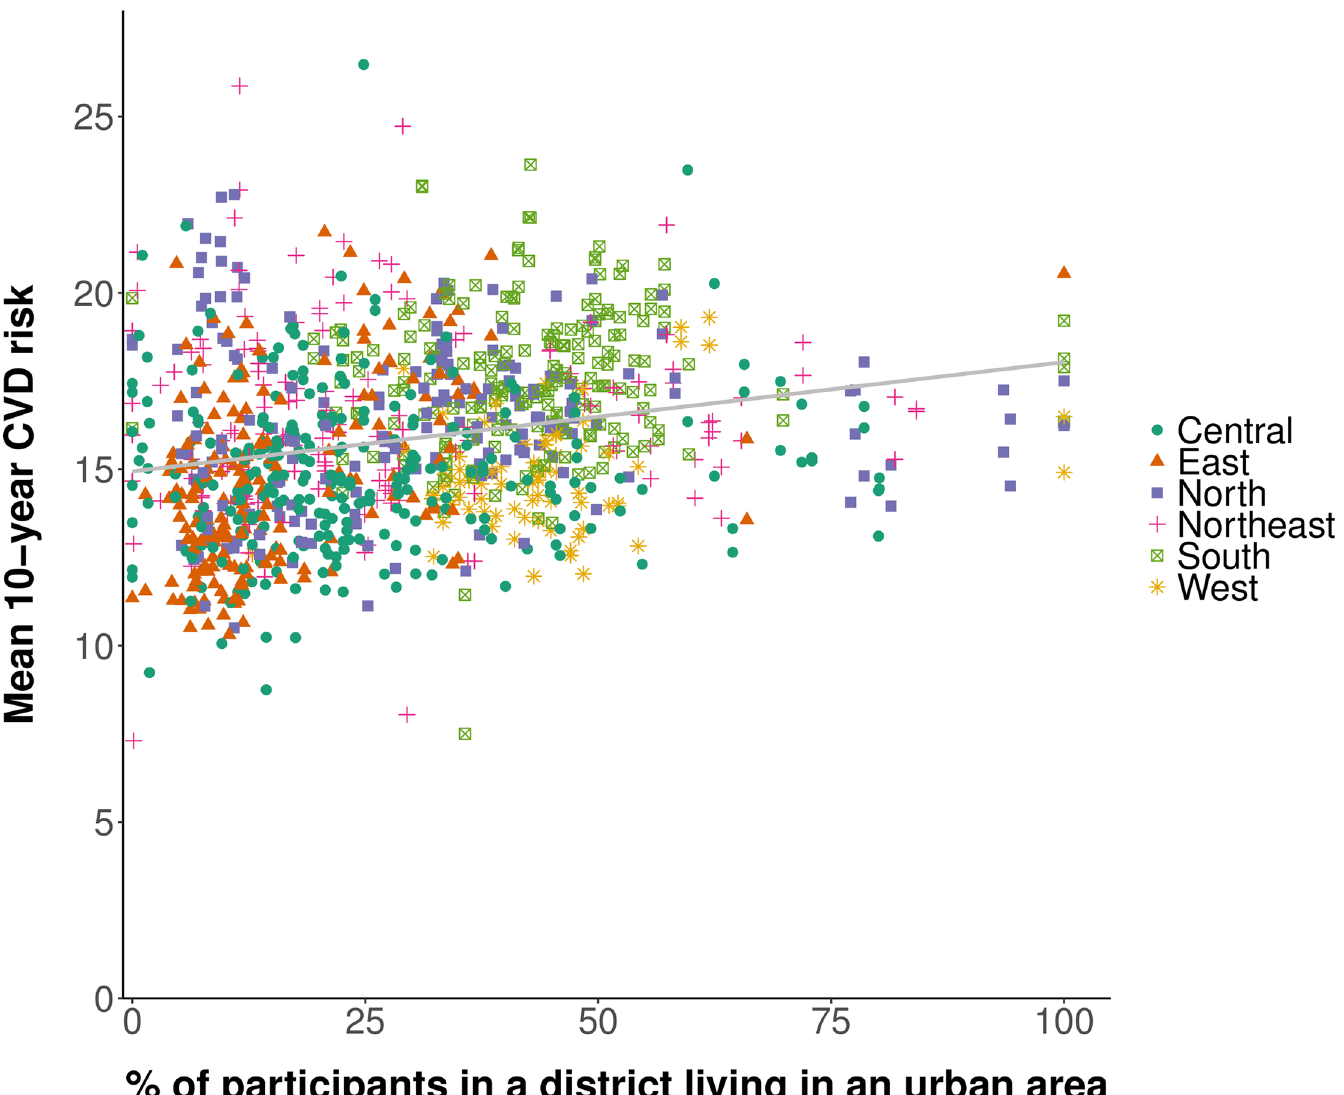
Fig 6. Association between the age-standardized district-level mean 10-year cardiovascular disease risk and urbanization. Mean 10-year risk of a cardiovascular disease (CVD) event was calculated using the Framingham risk score. Urbanization refers to the district-level percentage of adults aged 30 to 74 years in our sample who were living in an urban area. Age standardization was to the Global Burden of Disease project’s 2013 population structure for India [36]. The sample in each district was restricted to those aged 30 to 74 years. States and districts were divided into regions as per their allocation to Zonal Councils by the Government of India [39]. The grey line was fitted using ordinary least squares regression (with each data point in the plot having the same